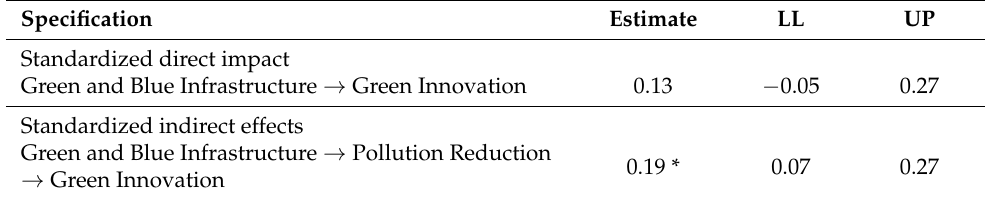
Table 4. Results for the indirect effect of pollution reduction.